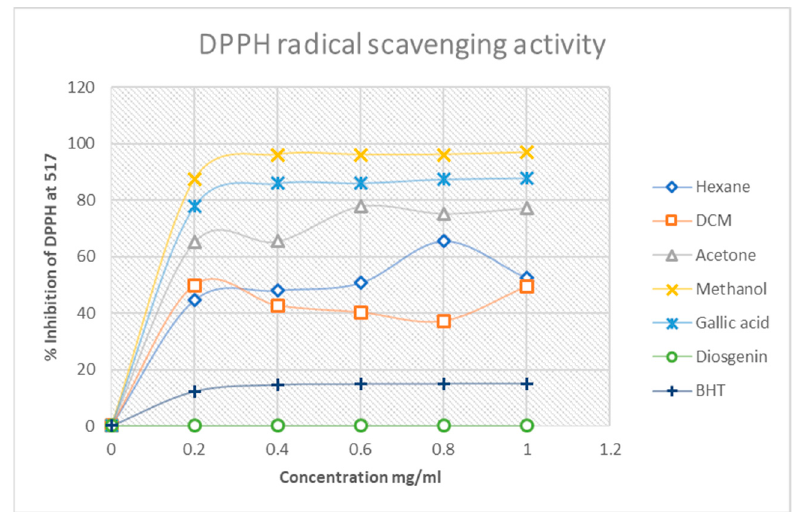
Figure 3. DPPH free-radical scavenging percentage inhibition of Mistletoe extracts and standards. Each value is expressed as mean ± standard deviation ( n = 3).